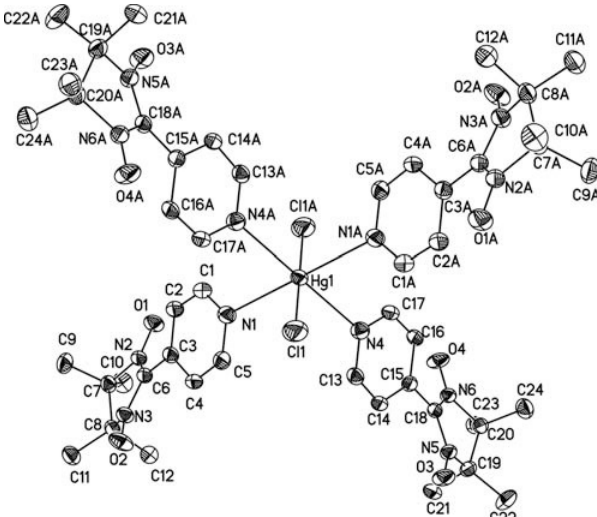
Table 1. Data collection and handling.